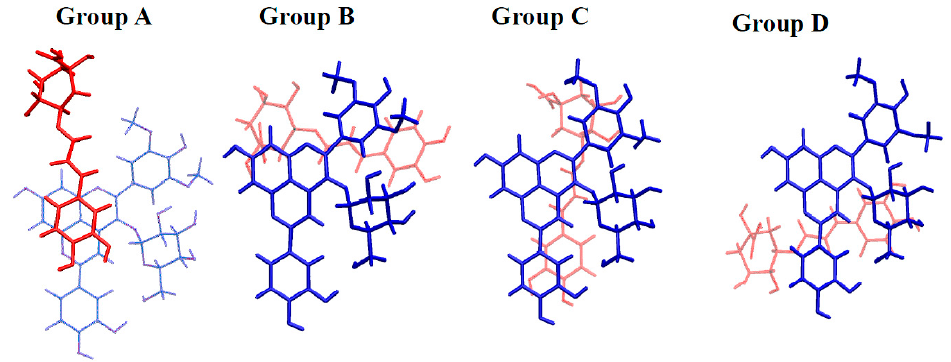
Figure 11. Four representative conformers of copigmentation complexes between PA1 (blue) and